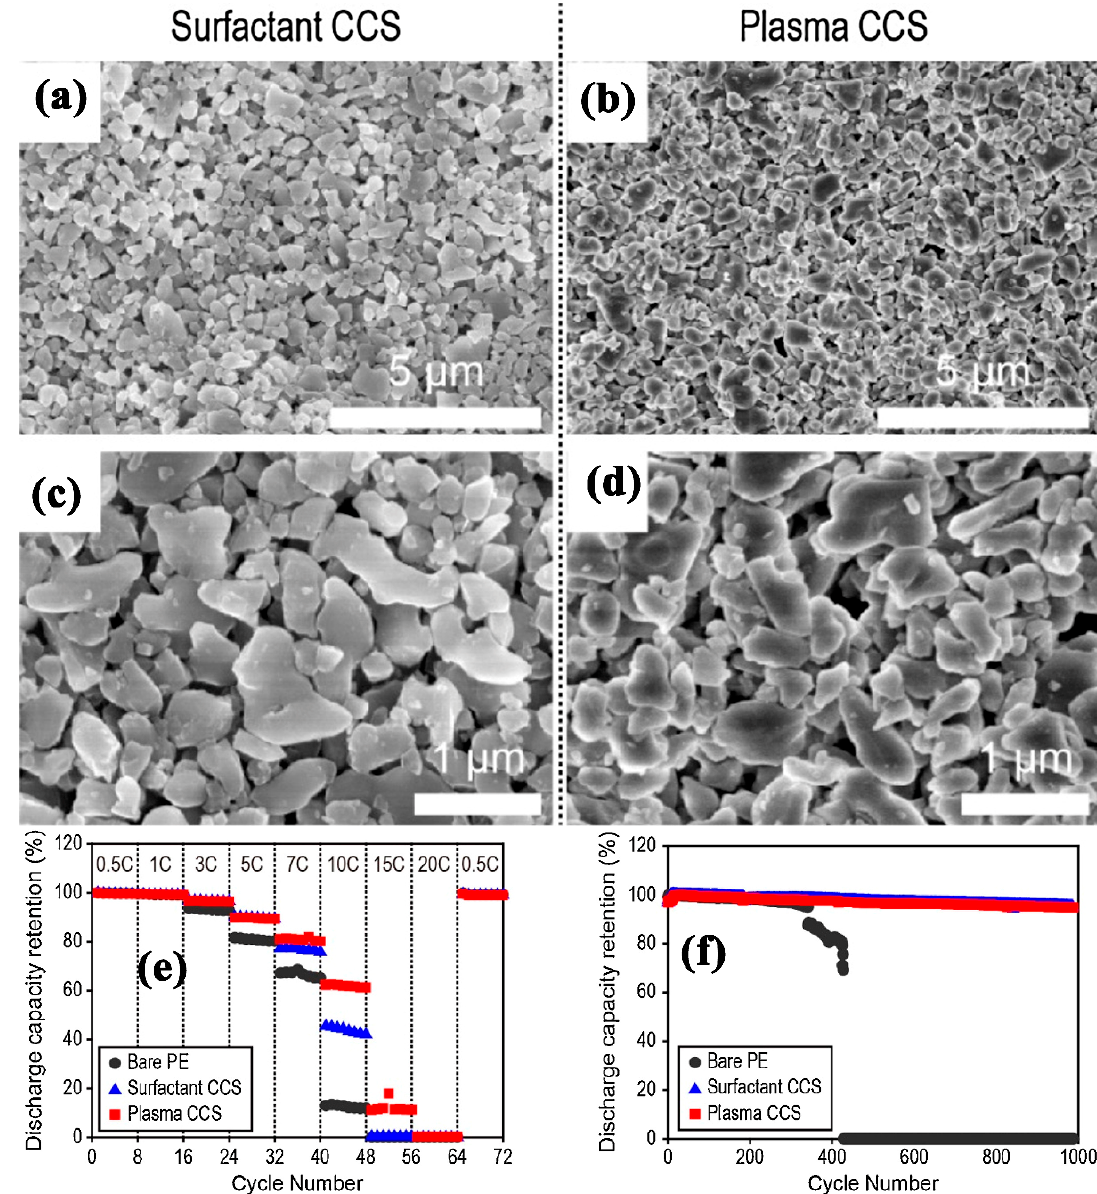
Figure 3. Top view of ( a,b ) surfactant treated ( b,d ) plasma treated Al 2 O 3 ceramic-coated PE separators ( e ) discharge capacity at different C rate and ( f ) discharge capacity of the unit cells for 1000 cycles [78], with copyright permission from Elsevier.